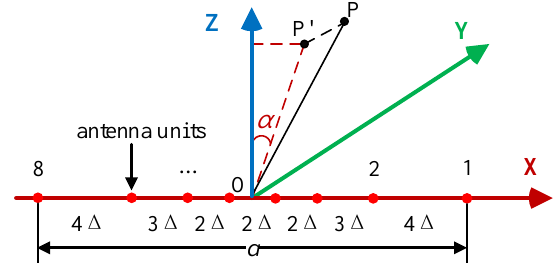
Figure 1. Linear array